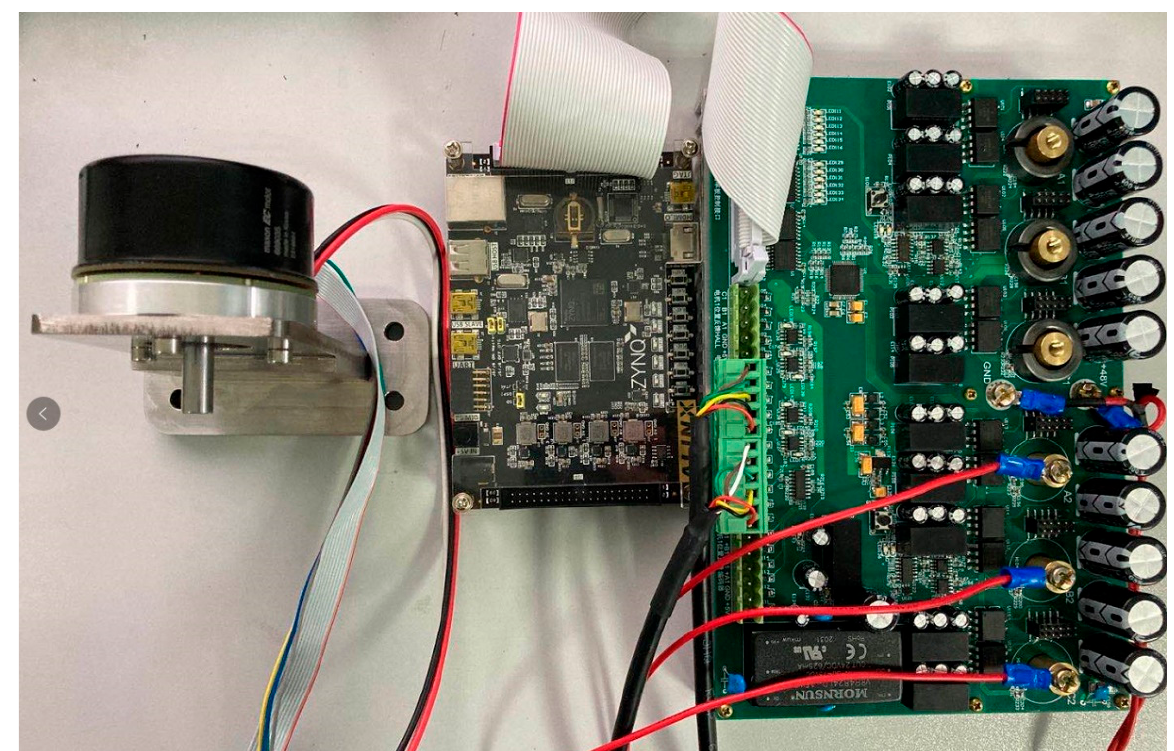
Figure 7. Test bench.